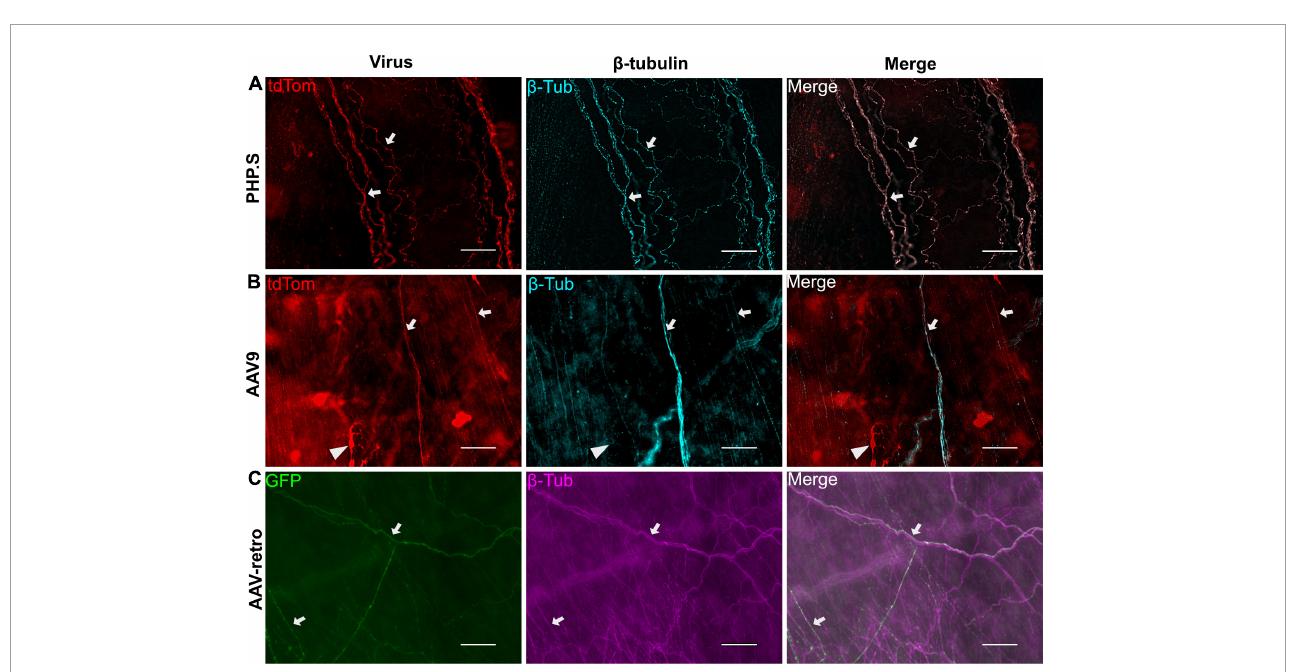
FIGURE4 Example of urinary bladder neuronal transduction. (A) Representative images from the PHP.S group showing colocalization of β -tubulin with tdTomato (scale bar, 50 µ m). (B) Representative images from the AAV9 group showing colocalization of β -tubulin with tdTomato (scale bar, 50 µ m). The white triangle points to a non-neuronal cell expressing tdTomato. (C) Representative images from the AAV-retro group showing colocalization of β -tubulin with GFP (scale bar, 50 µ m). White arrows indicate transduced nerve fibers.